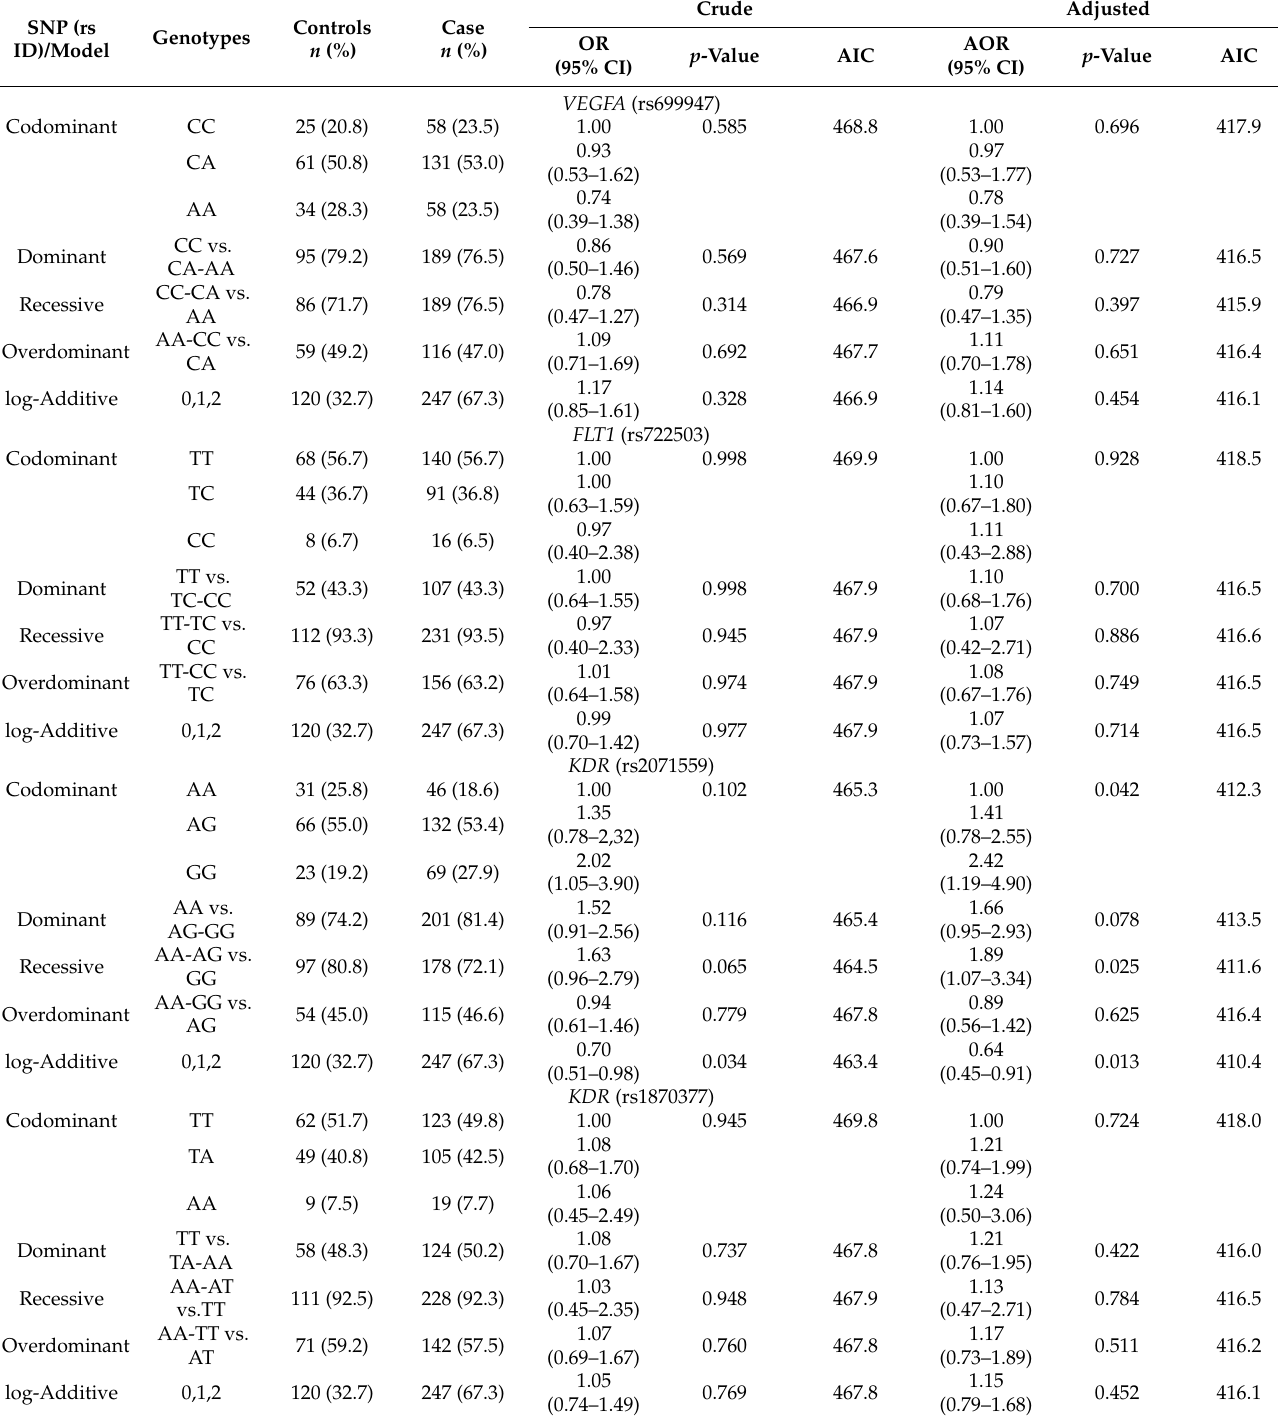
Table 3. Genotypic frequencies of selected polymorphisms of genes encoding angiogenesis related factors between infertile women and